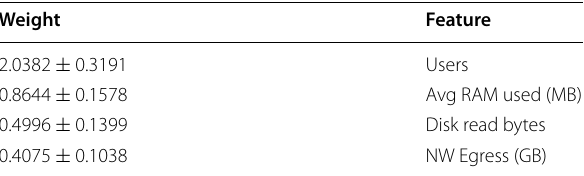
Table 9 Permutation importance feature rank for QoS model of MRS